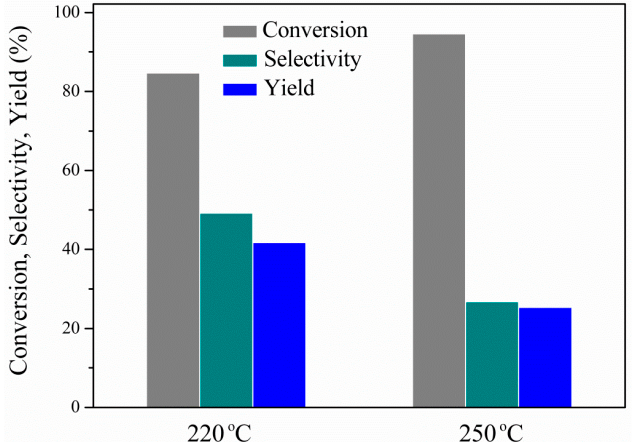
Figure 6. Effect of reaction temperature on glycerol conversion, 1,2-PDO selectivity and yield: 3.5 MPa N 2 initial pressure, 4 h, 7.1 wt% EtOH, 11.3 wt% glycerol (ethanol/glycerol molar ratio = 1.25) and water, catalyst/glycerol + ethanol weight ratio = 0.06.